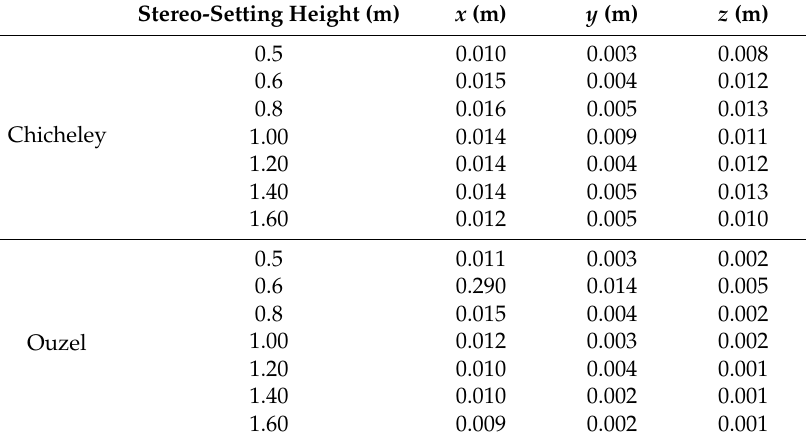
Table 6. Co-registration errors obtained from the 3D Structure from Motion (SfM) model of the riverine environment at each study site. Results refer to each of the 10 m study sites selected for the stereo-camera calibration